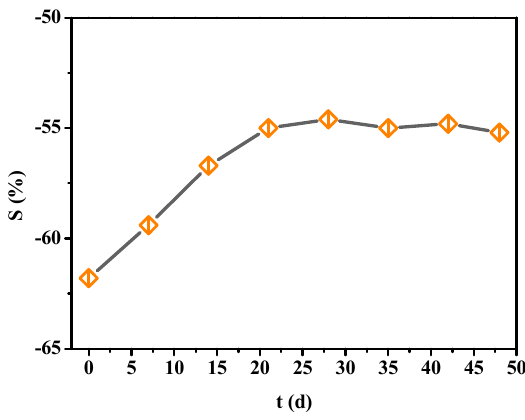
Figure 12. Stability curves of PANI-HCl/SSA sensor to H 2 S.